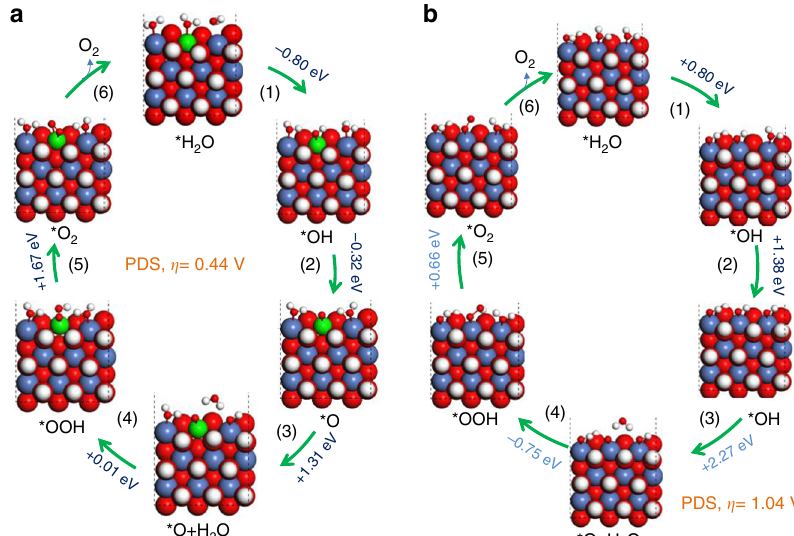
Fig. 5 DFT calculation. Mechanism of OER on ( a ) W-doped Ni(OH) 2 and ( b ) bare Ni(OH) 2 catalyst based on DFT calculations, in which red, white, green, and blue atoms represent the oxygen, hydrogen, nickel, and tungsten atoms, respectively. Note that the symbols of “ + ” and “ − ” represent endothermic and exothermic free energy. For the step from State 6 to State 1, 1.0 eV, and 0.4 eV endothermic free energy values were required for the doped and bare samples, respectively, where these free energy changes are not shown